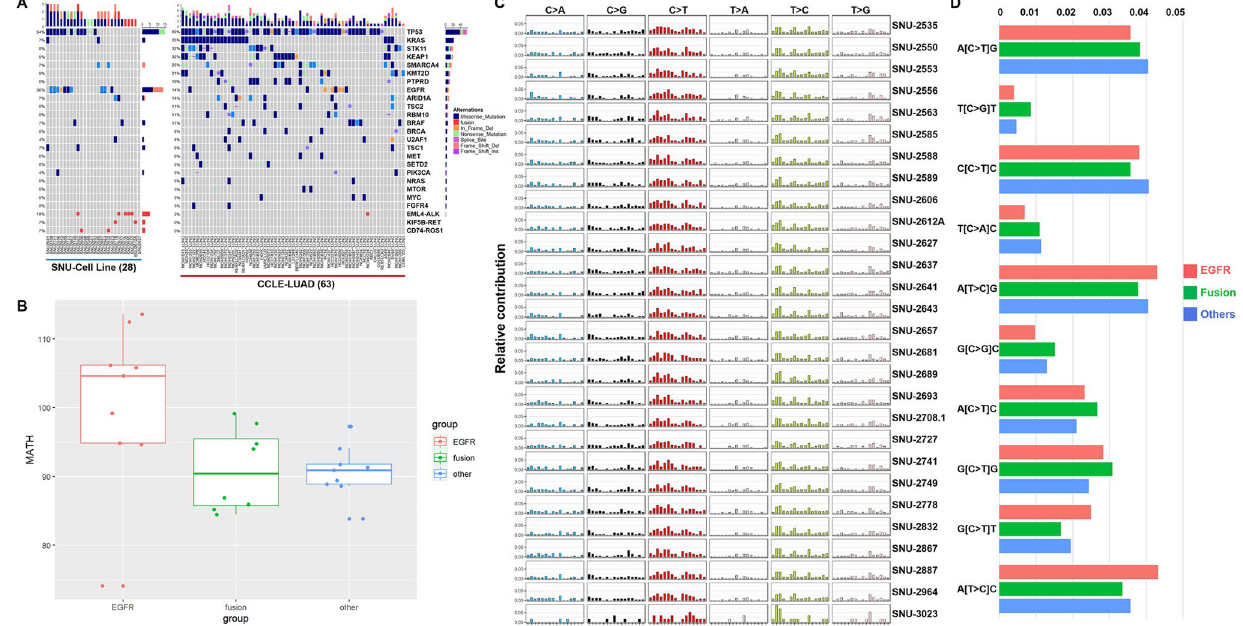
Figure 2. The characteristic genetic mutations of MPE-derived lung cancer cell lines. ( A ) See also Table 1. Comparison between the mutational landscape of MPE-derived cell lines ( n = 28) and CCLE-LUAD cell lines ( n = 63). MPE-derived cell lines harbored higher rates of the EGFR mutation as well as the fusion events. Each type of mutations is marked with representative colors on the waterfall plot. The total mutational loads are indicated on the top (per each cell lines) and right side (per each cohorts) of the plot. The percentage of mutational occurrence within the cohort is specified on the left side of the plot. ( B) See also Supplementary Table 3. The MATH score demonstrated EGFR -mutant group had higher genetic heterogeneity score. Interquartile ranges with the median value are indicated on the box plot. Each group is marked